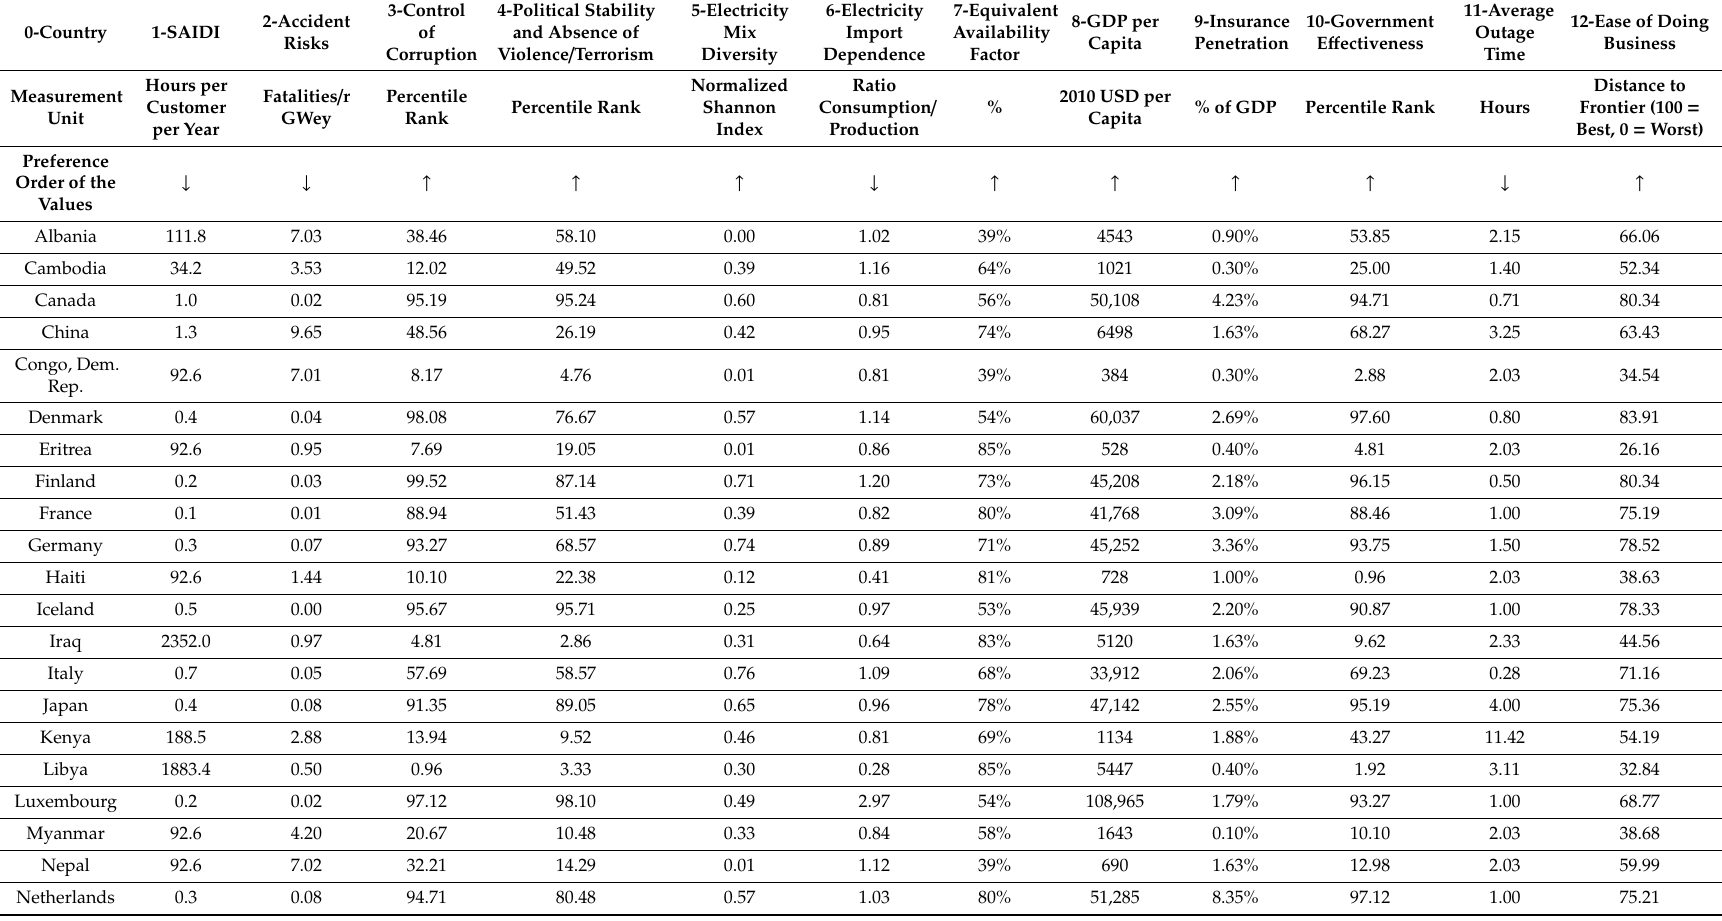
Table 2. Performance matrix with selected countries and 12 indicators. The table including all 140 countries is available in Table S1 in the electronic supplementary information (ESI). For the preference order of the values, an upward pointing arrow indicates better performance for higher values (positive preference order), whereas a downward pointing arrow indicates better performance for lower values (negative preference